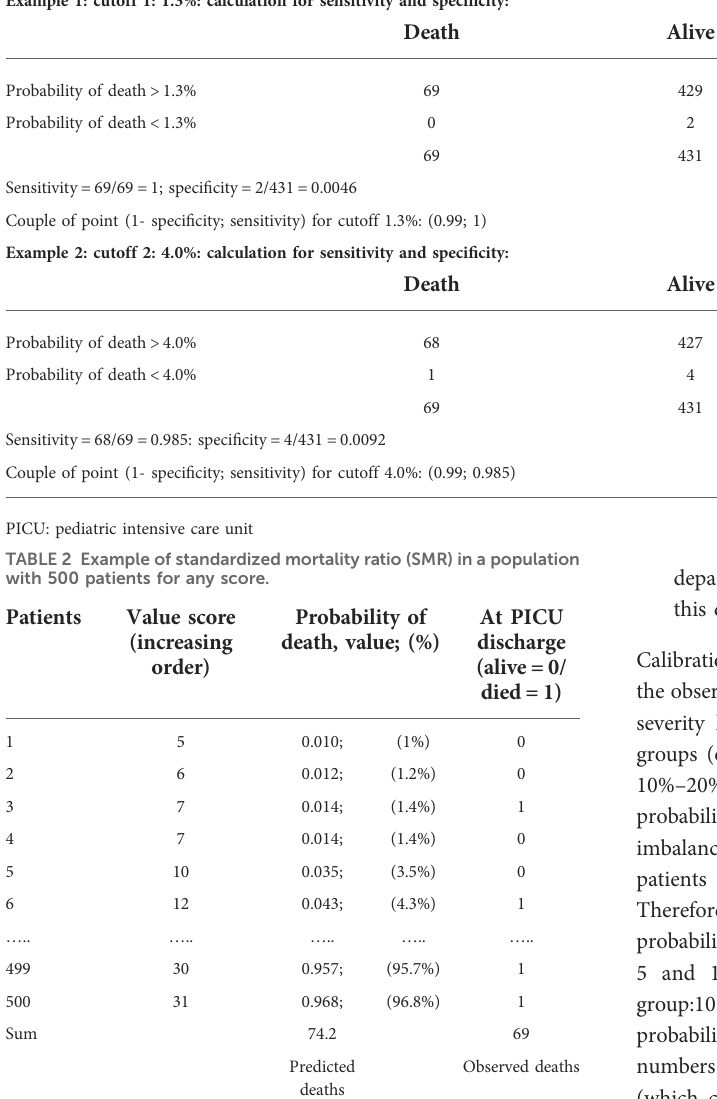
5 and 10 groups with the same number of patients per group:10 groups correspond to the deciles of predicted probabilities ( Table 3 ) (40). In each group, two predicted numbers were calculated: the number of predicted deaths (which corresponds to the sum of the predicted probabilities of death for all individuals in the group) and the number of predicted alive patients (=1-sum OF “ predicted probabilities of deaths ” ). When considering deaths, two factors are